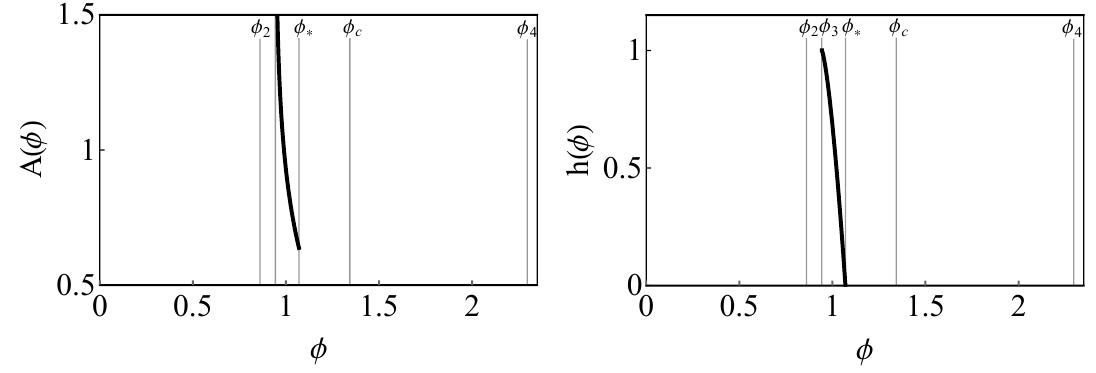
Figure 9 . Numerical solution describing the thermal state with non-zero VEV in the CFT 3 . This (cid:13)ow is obtained for (cid:30) H = (cid:30) (cid:3)